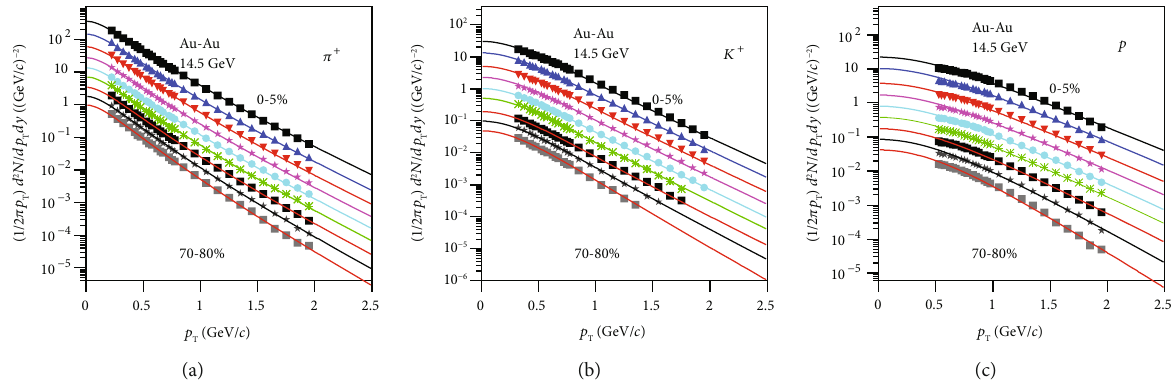
Figure 3: The same as Figure 1, but showing the results at